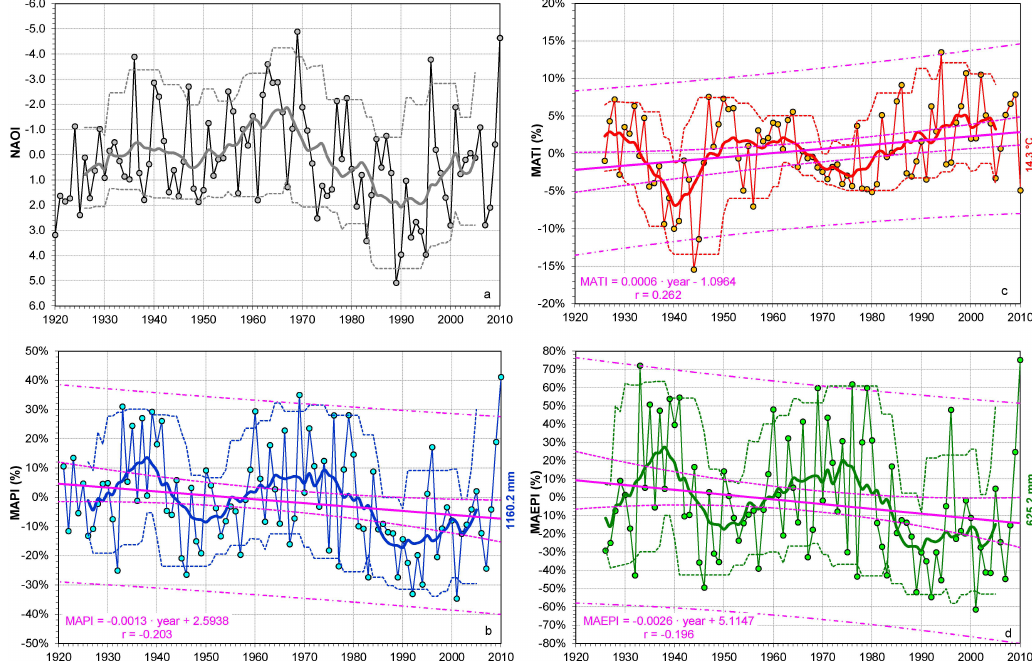
Fig. 2. Time series of (a) winter NAOI time series monitored between Lisbon (Portugal) and Stykkisholmur/Reykjavik (Iceland). (b) MAPI; (c) MATI; (d) MAEPI. Key to symbols: continuous magenta lines=linear trend of the whole time series (equation and coefficient of correla- tion in the lower left corner); dashed magenta lines=95% confidence interval of the expected mean value; dash-dotted magenta lines=95% prediction interval of the expected value; continuous thick line=11-yr moving average centred on the sixth year; dashed lines=11-yr moving percentiles of 5th and 95th centred on the sixth year; number on right side of the graphs=absolute mean value of the whole time